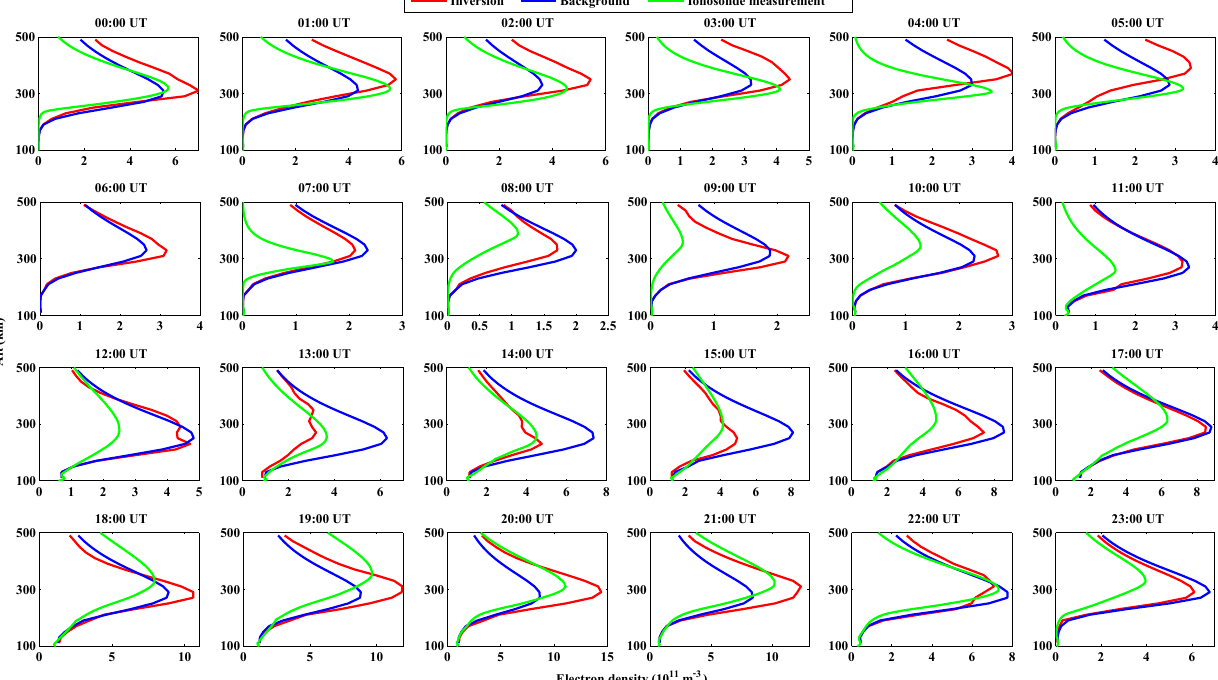
Figure 12. The comparisons between the reconstructed electron density profiles near the MHJ station and the measured electron density profiles from ground ionosonde under the relatively active geomagnetic activity condition; LT = UT −